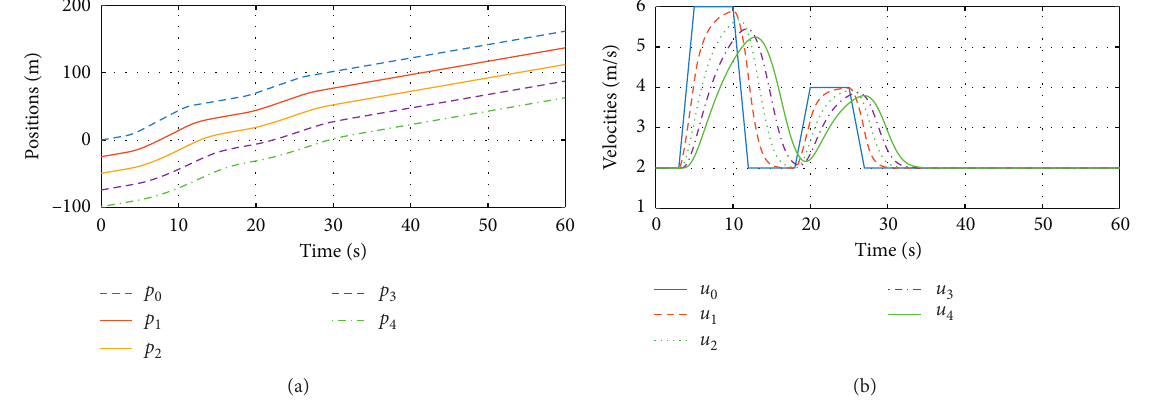
Figure 1: Positions and velocities of vehicles.